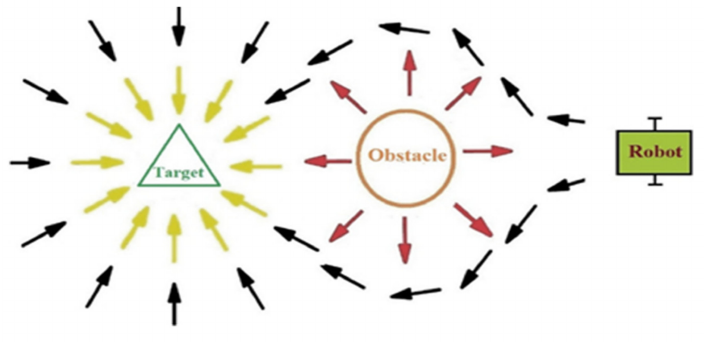
Figure 10. Artificial potential field [298].